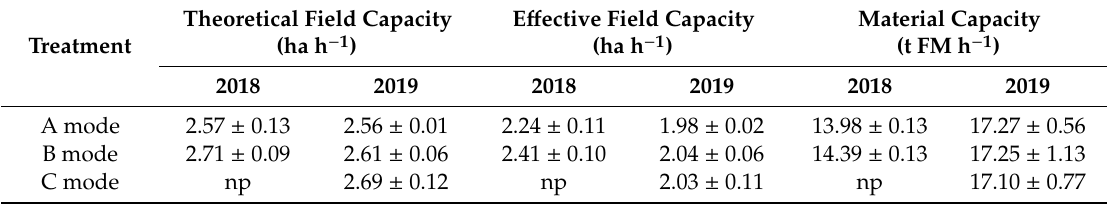
Table 3. Combine performance in 2018 and 2019 according to the working arrangements (treatments).